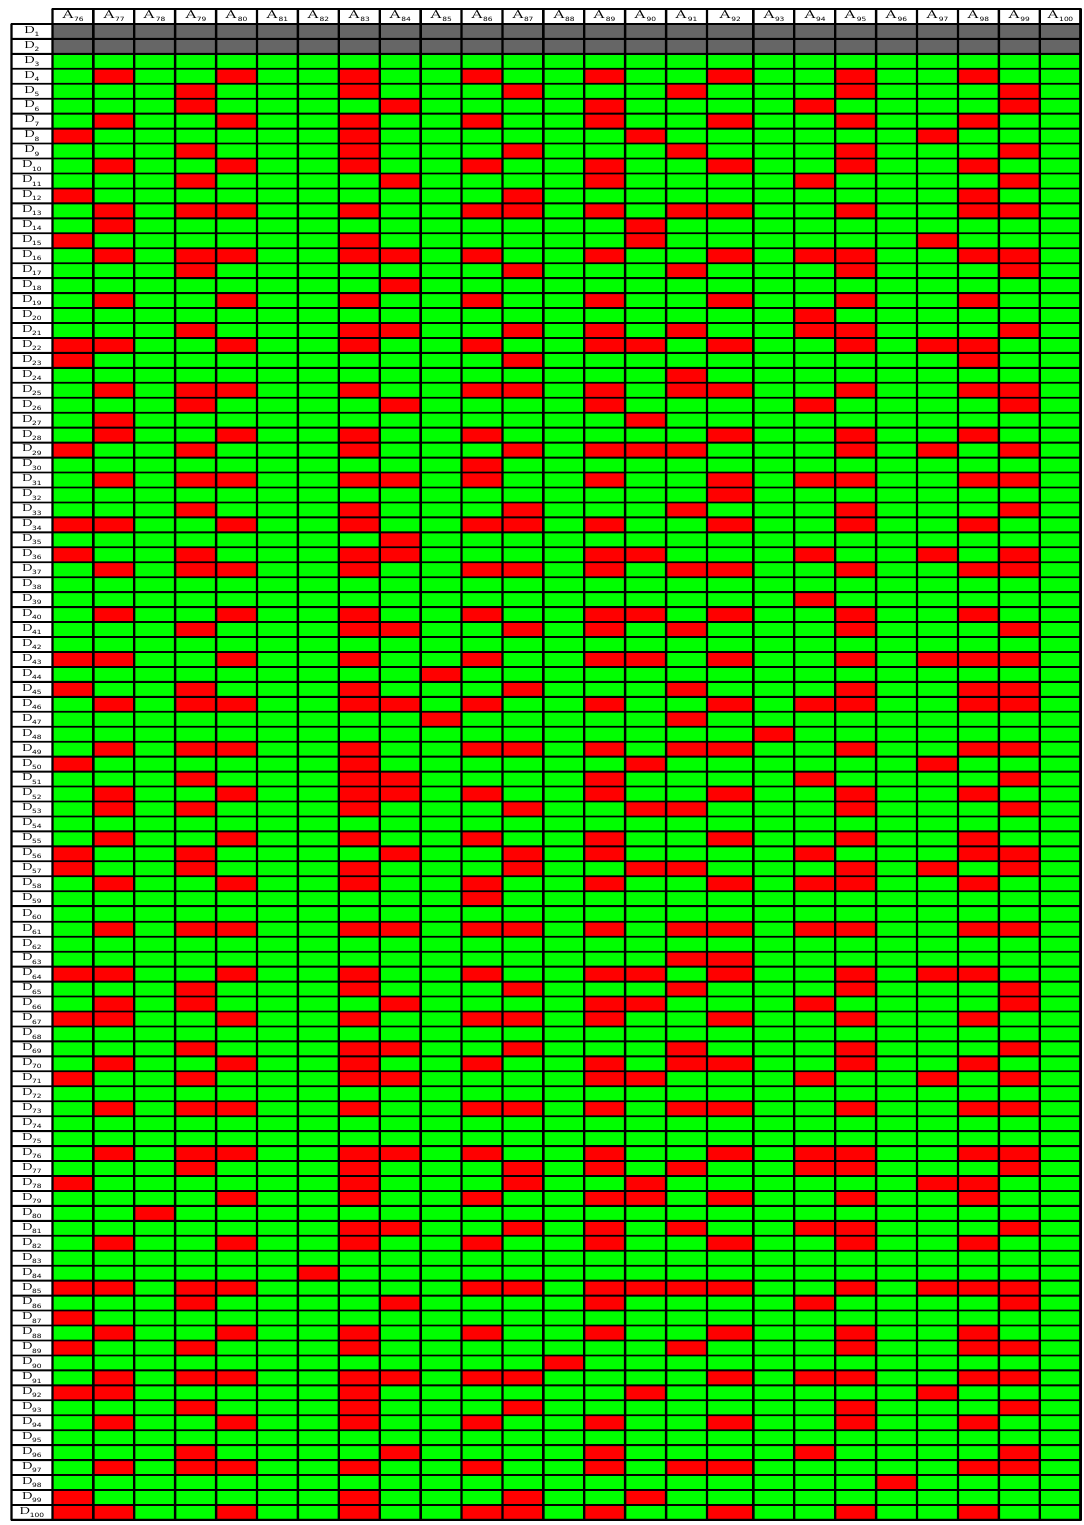
Table 9 . Analyzed theories for ( D n ; A m ) with n = 3 ; : : : 100 and m = 75 ; : : : 100.